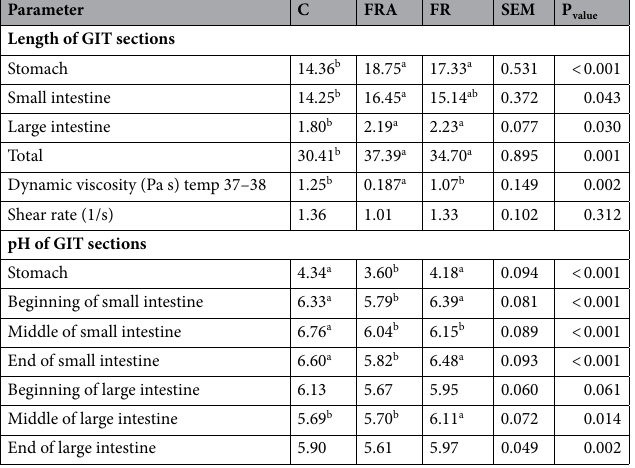
Table 1. Characteristics of the gastrointestinal tract (GIT) of weaners. Feeding groups: C control group, FRA weaners receiving a diet with 8% FRSMb and feed additives, FR weaners receiving a diet with 8% FRSMb without feed additives. a,b Means within a row with different superscripts differ significantly (p ≤